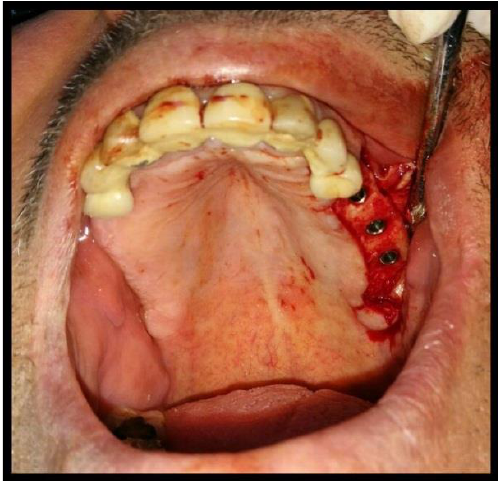
Figure 1: Placement of dental implants through the palatal bias incision Flapless Procedure (Study Group)